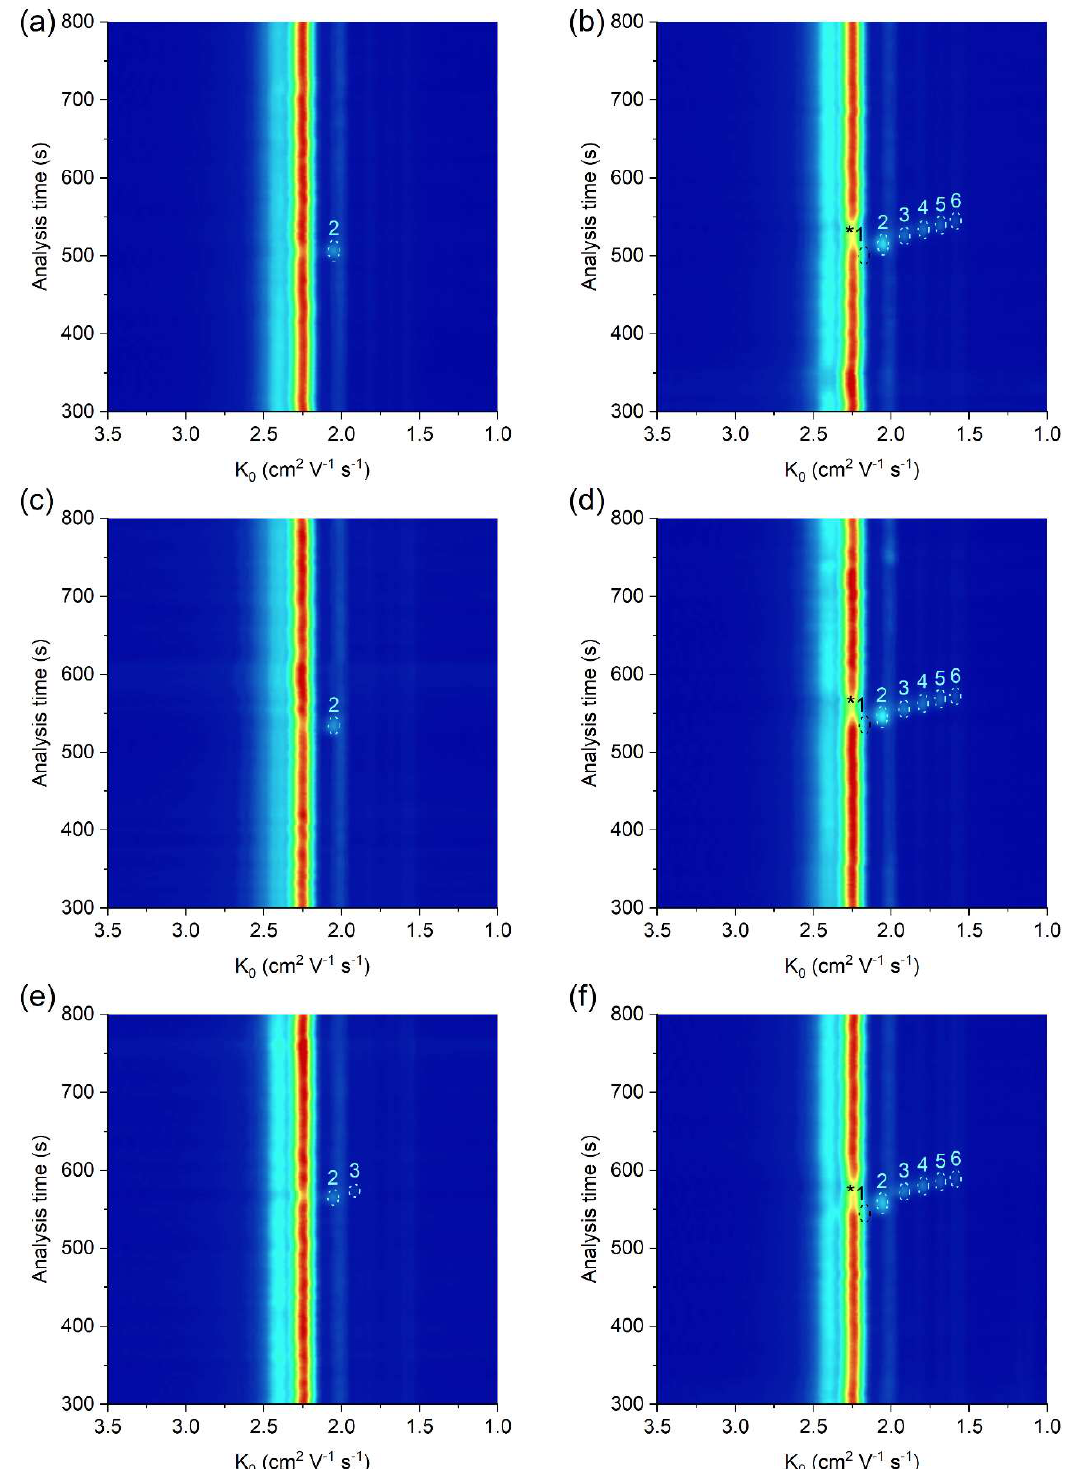
Figure 4. µITP-IMS analysis of ( a ) 4000-times diluted apple vinegar, ( b ) 4000-times diluted apple vinegar with addition of 20 mg L −1 of C 1 -C 6 carboxylic acids, ( c ) 2000-times diluted ear drops, ( d ) 2000-times diluted ear drops with addition of 20 mg L −1 of C 1 -C 6 carboxylic acids, ( e ) 10-times diluted saliva, ( f ) 10-times diluted saliva with addition of 20 mg L −1 of C 1 -C 6 carboxylic acids. Formic acid (1), acetic acid (2), propionic acid (3), butyric acid (4), valeric acid (5) and caproic acid (6). Auxiliary liquid: 10% TE; flow rate: 30 µL min −1 . Other µITP-IMS parameters are given in Materials and Methods. * position of the analyte.